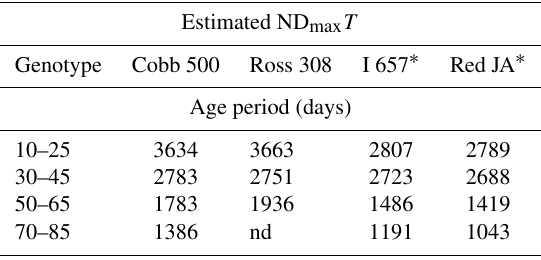
Table 3. Age-dependent ND max T [mgN(BW 0 . 67 older male meat-type chicken genotypes (earlier data as summa- rized by Liebert,